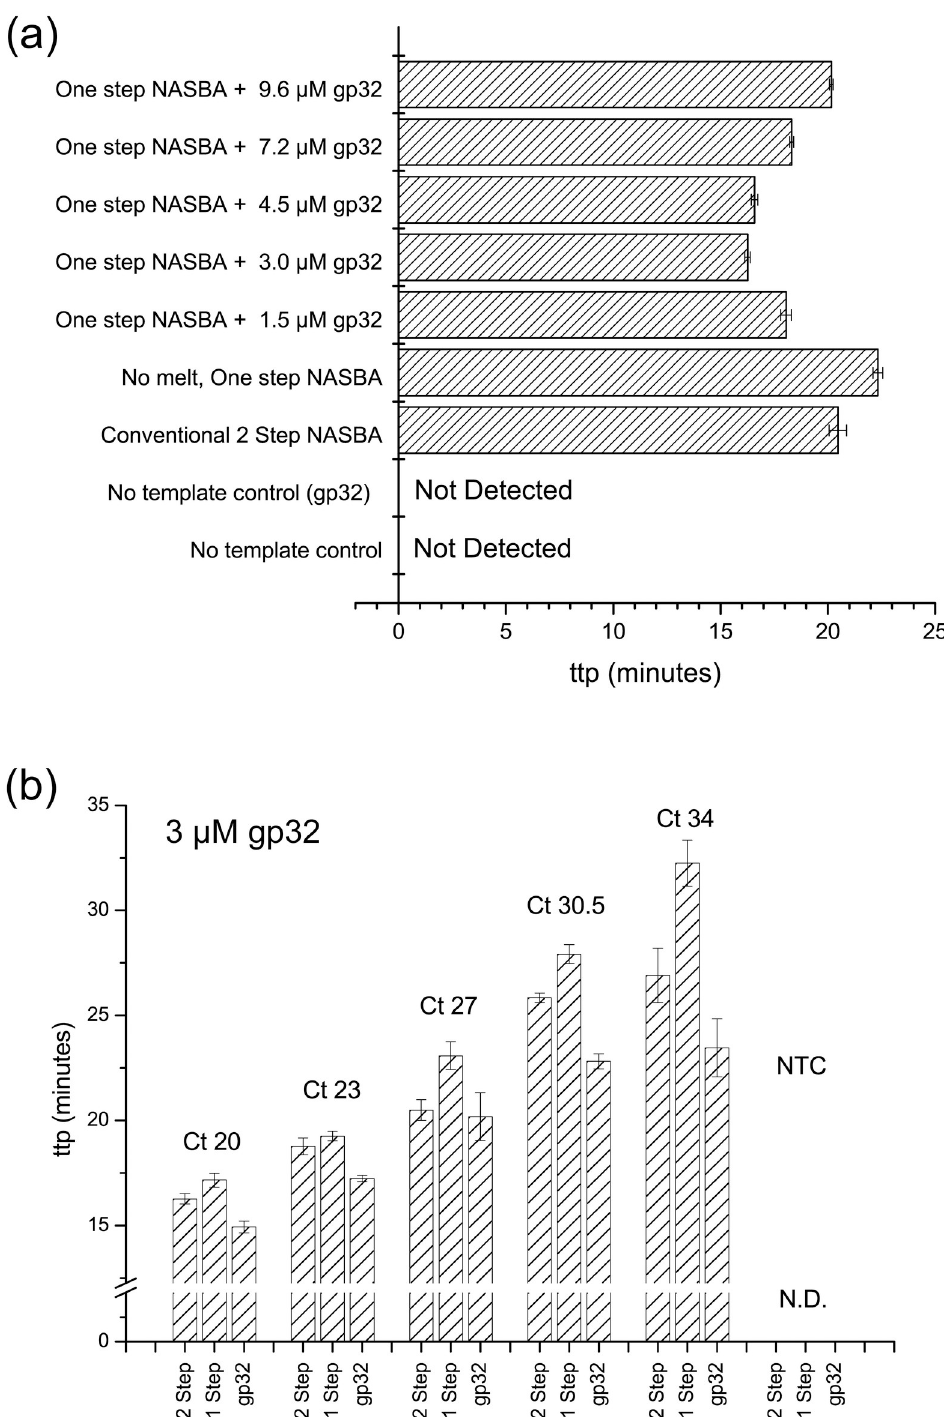
Fig 3. (a) Effect of gp32 protein on the ttp for HIV-1 using NASBA and HIV-1 primer set (S1 File) (n = 3). (a) Optimization of gp32 using 0, 3, 4.5, 7.2 and 9.6 μ M (0, 100, 150, 240, 320 ng/ μ L) gp32. Sample contained ~1 x 10 5 copies of synthetic HIV-1 RNA; conventional 2-step NASBA included as reference, NTCs as 2-step (no gp32) and 1-step (with 4.5 μ M gp32) (b) Comparison of NASBA carried out as conventional 2-step, one step in absence of SSB, and 1-step using 3 μ M gp32 for HIV-1 RNA samples ranging from C t 20 (~1.5 x 10 6 copies) to C t 34 (~1.5 x 10 2 copies).